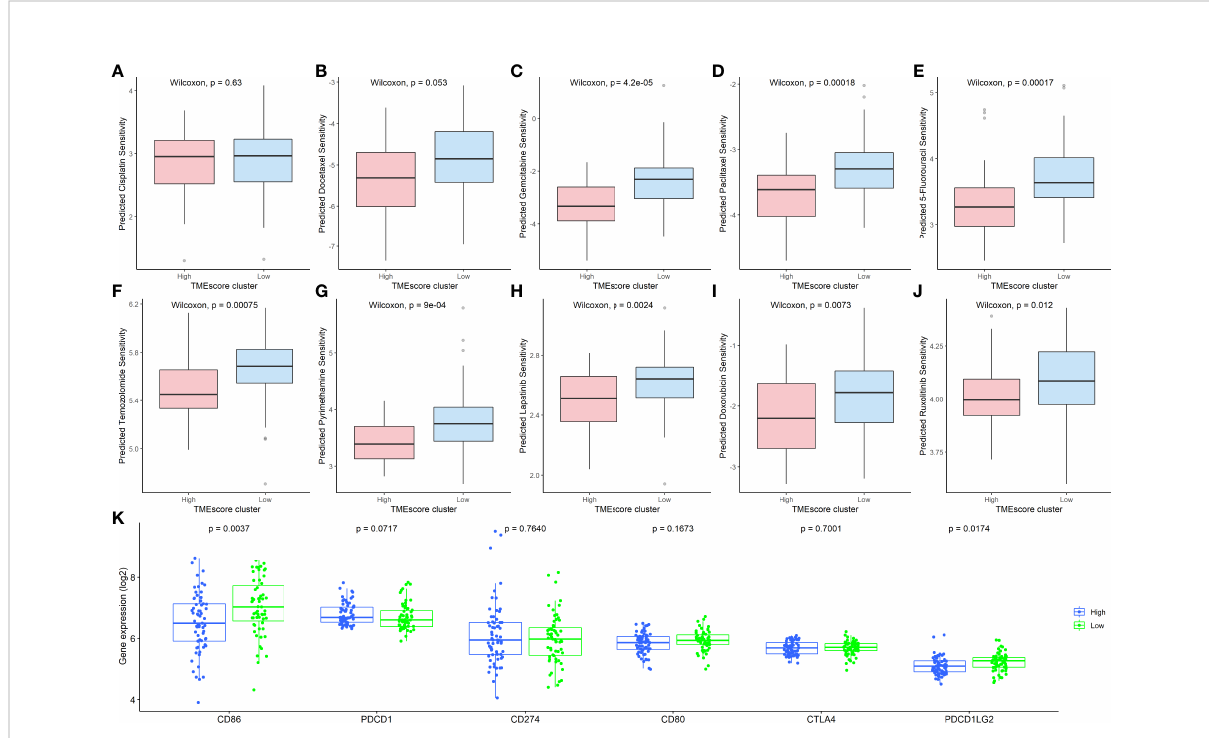
FIGURE 4 Clinical therapeutic strategies using the TIIC-related DEGs. Comparison of the IC50 values between the TMEscore-H and TMEscore-L groups of (A) Cisplatin; (B) : Docetaxel; (C) Gemcitabine; (D) Paclitaxel; (E) 5-Fluorouracil; (F) Temozolomide; (G) Pyrimethamine; (H) Lapatinib; (I) Doxorubicin; (J) Ruxolitinib; (K) Comparison of six immune checkpoint inhibitors between TMEscore clusters. TIIC, tumor-in fi ltrating immune cell; DEG, differentially expressed gene; IC50, half-maximal inhibitory concentration; TMEscore, tumor microenvironment score, TMEscore-H, high TMEscore; TMEscore-L, low